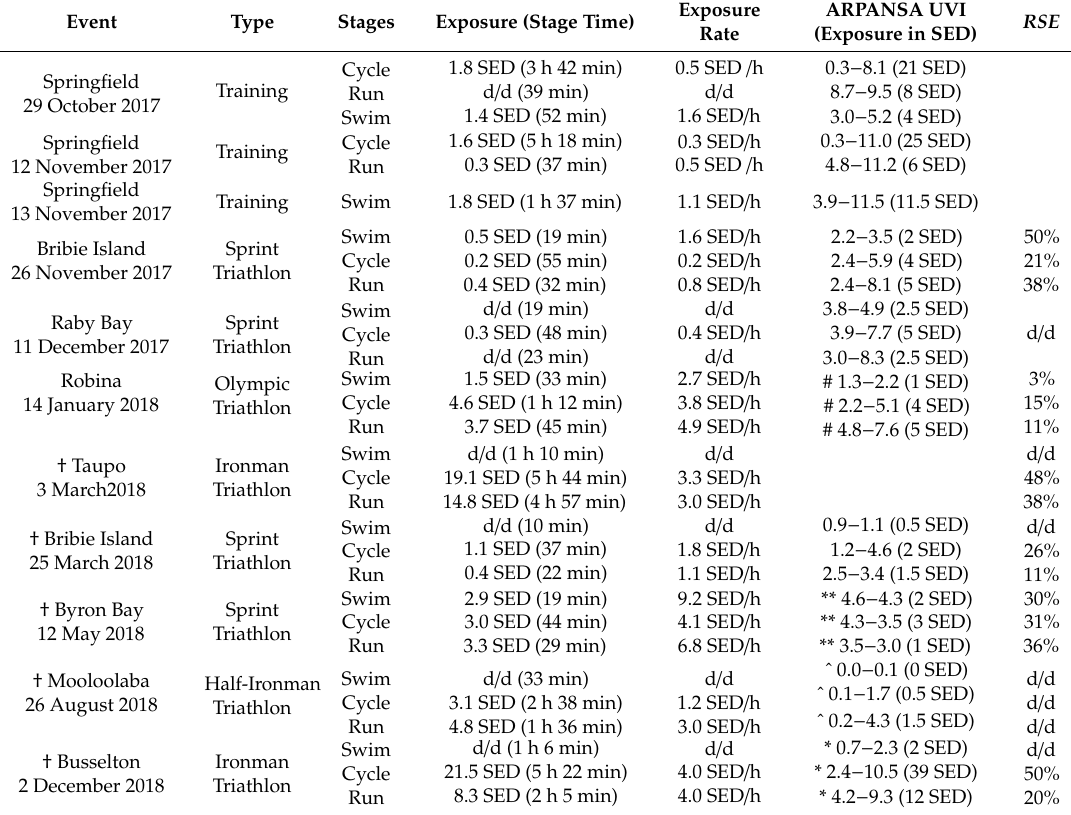
Table 4. Participant training and triathlon UV exposure, including relative stage exposure ( RSE ) for triathlons measured with respect to event ambient dosimeters. d / d = damaged dosimeter. ARPANSA UVI = ambient UVI during event stages [21] including integrated exposure in standard erythema dose (SED) [27]. (UV: Ultraviolet, UVI: UV